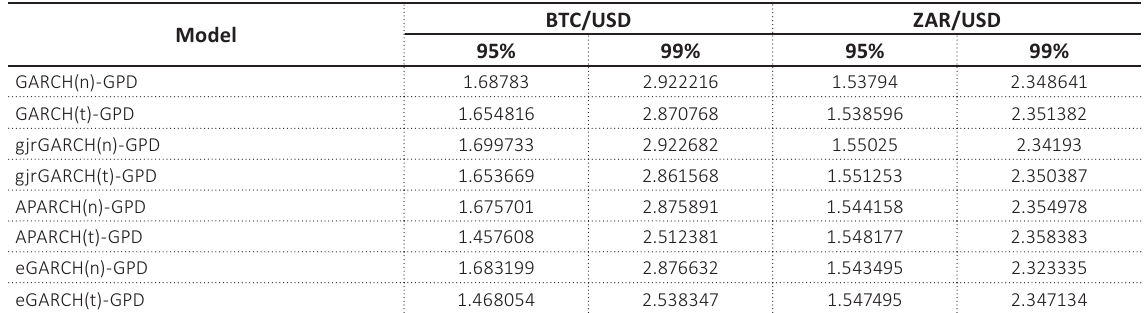
Table 5. VaR estimates using fitted hybrid